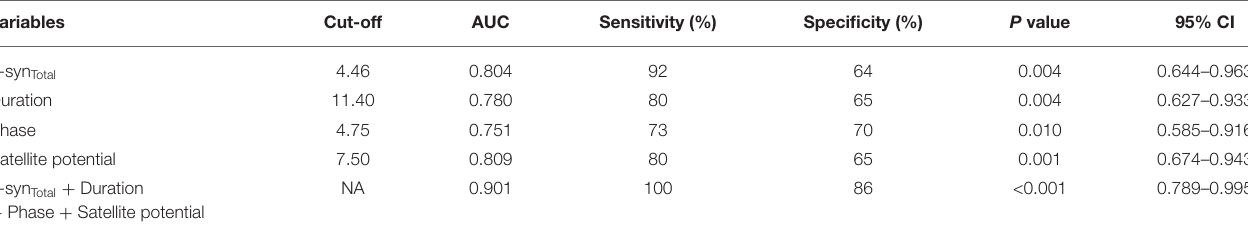
TABLE 3 | ROC curve of α -syn Total in EVs of saliva and indexes of EAS-EMG (including duration, phase, and satellite potential) between MSA-P and PD. Variables Cut-off AUC Sensitivity (%) Specificity (%)